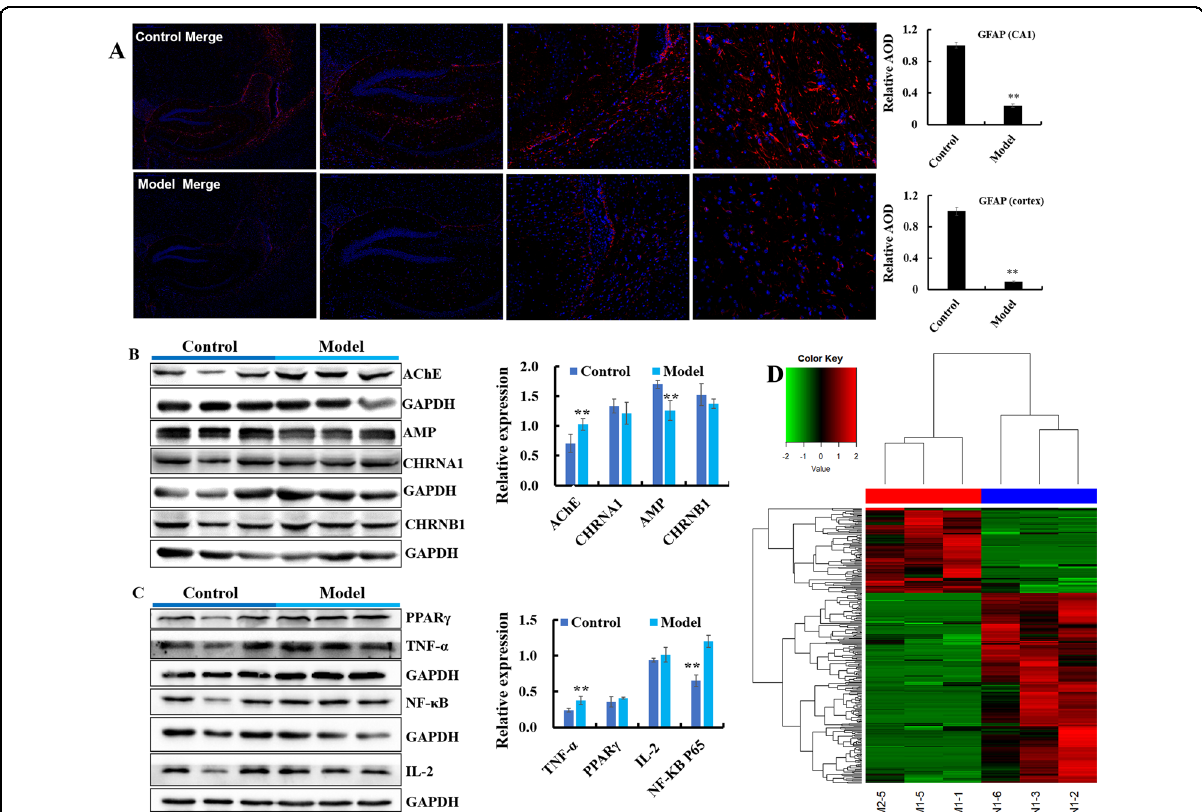
Fig. 3 Dysbacteriosis affects brain functions and circRNA sequencing in mice fed a diet high in sugar and fat for 4 months. A Samples were stained using an immuno fl uorescent antibody of GFAP, see also Fig. S3B-a. B , C Dysbacteriosis implicated the cholinergic system, in fl ammation and immune system in the brain. D Heatmap showing different expression of circRNAs in brain samples from mice fed a diet high in sugar, see Table 1. Data are the mean ± SD of 3 independent experiments. * p < 0.05 and ** p < 0.01 vs. the model group by one-way ANOVA, followed by the Holm – Sidak